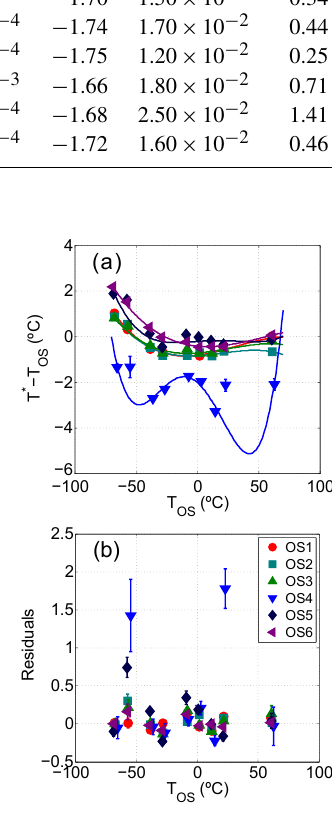
Figure A4. Calibration of the TC string during the CLOUD calibra- tion campaign: (a) fitted calibration curves (Eq. A2 with k s = 2) and (b) residuals from the calibration fit. There was a malfunction of the Pt100 sensor (PTH2) for TC2 so the PTH2 values were obtained by interpolation between PTH1 and PTH3.